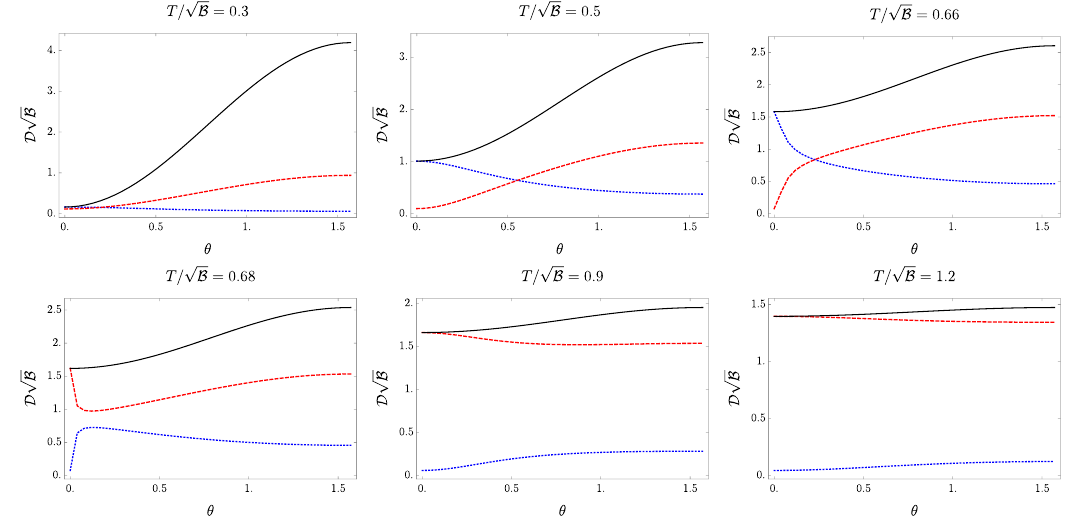
Figure 6 . Angular dependence of the (dimensionless) attenuation coe(cid:14)cients of Alfv(cid:19)en (black, solid), fast (blue, dotted) and slow (red, dashed) magnetosonic waves, D crossover and the weak-(cid:12)eld